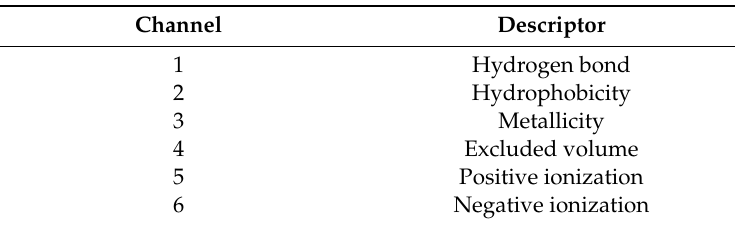
Table 2. The molecular descriptors.